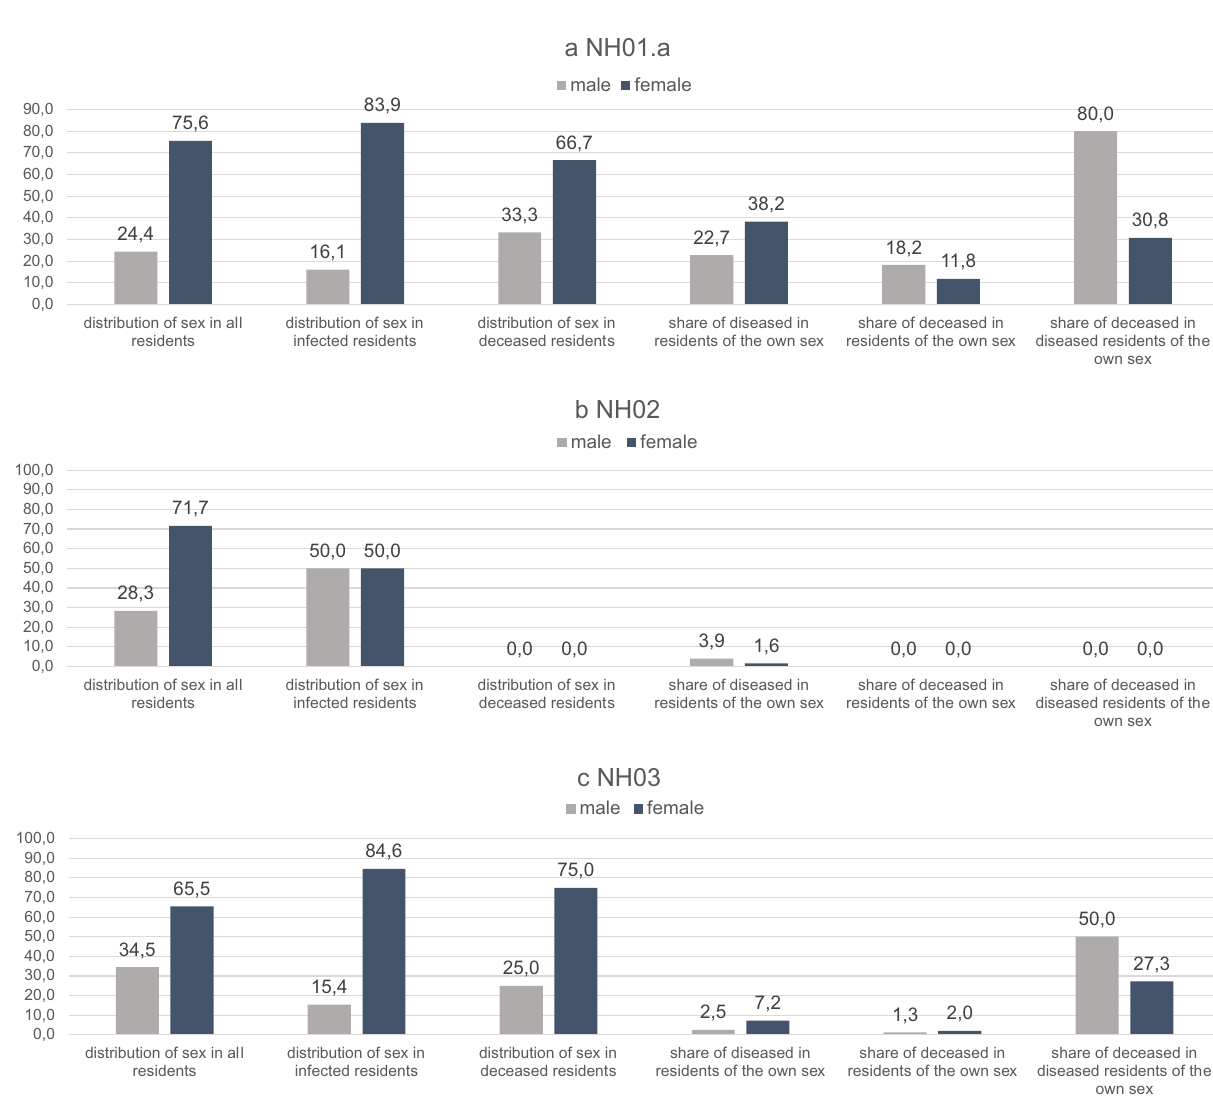
Figure 6. Sex distribution of diseased and deceased residents of the affected nursing homes. ( a ) Residents of NH01.a. Data are given in (%). ( b ) Residents of NH02. Data are given in (%). ( c ) Residents of NH03. Data are given in (%).